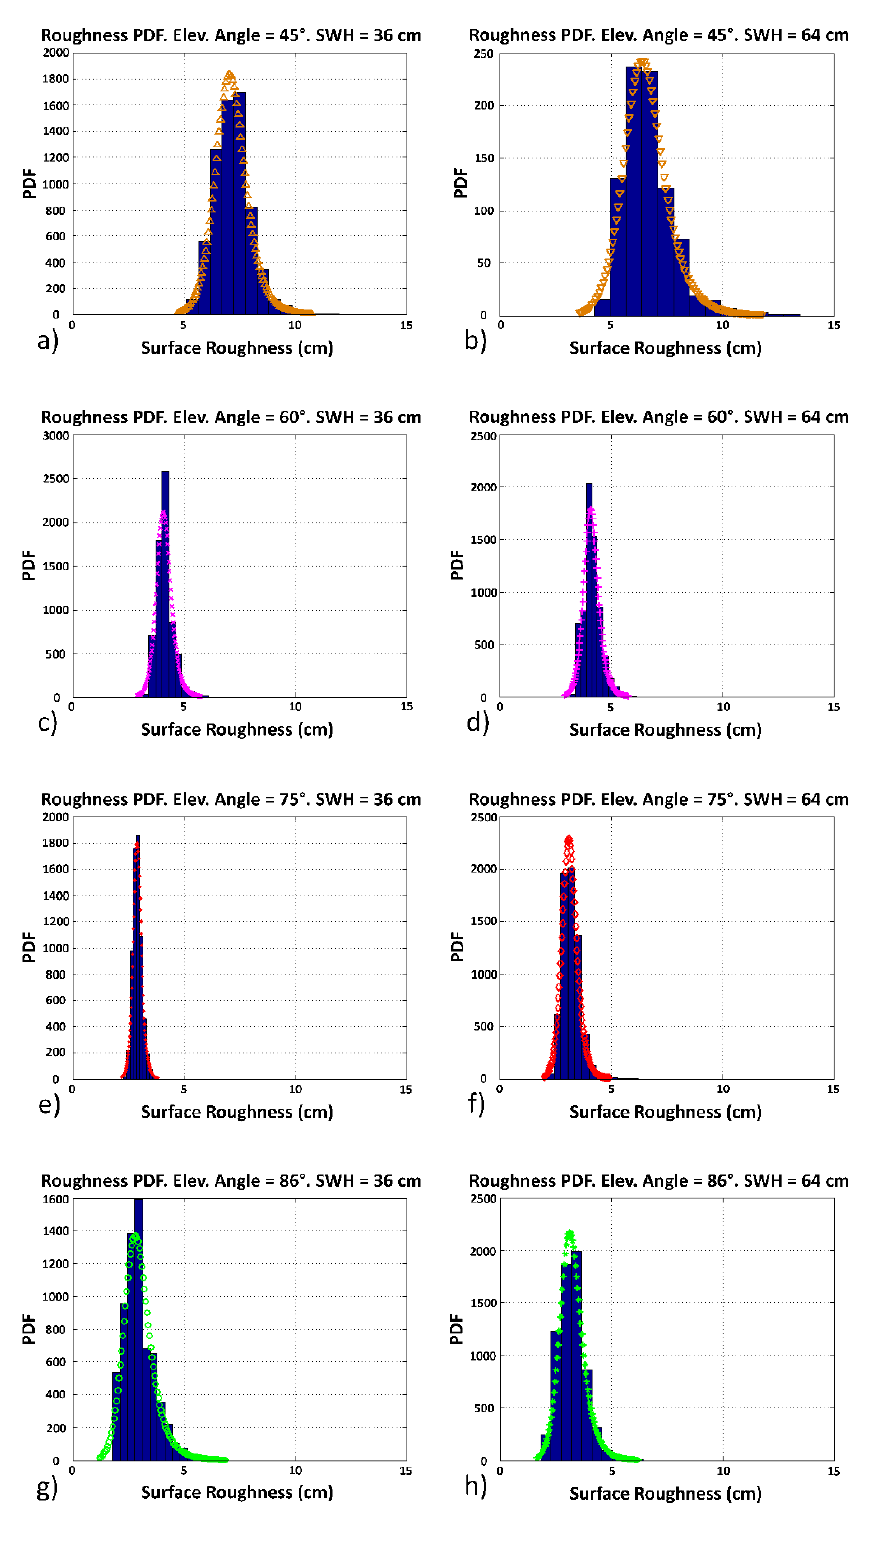
Figure 15. Theoretical log-logistic pdf approximation to the small-scale surface roughness distributions for an elevation angle of ( a , b ) θ = 86°; for (a,c,e,g) SWH = 36 cm and (b,d,f,h) for SWH = 64 cm. Note: the distributions θ e of the small-scale surface roughness have been derived using the standard deviation of the signal before